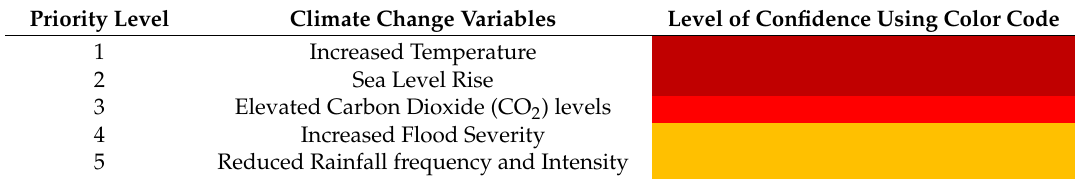
Figure 1. Map of the Study Area, the Coastal Zone of The Gambia. Table 1. List of Climate Change Variables and the Level of Confidence in Projections.